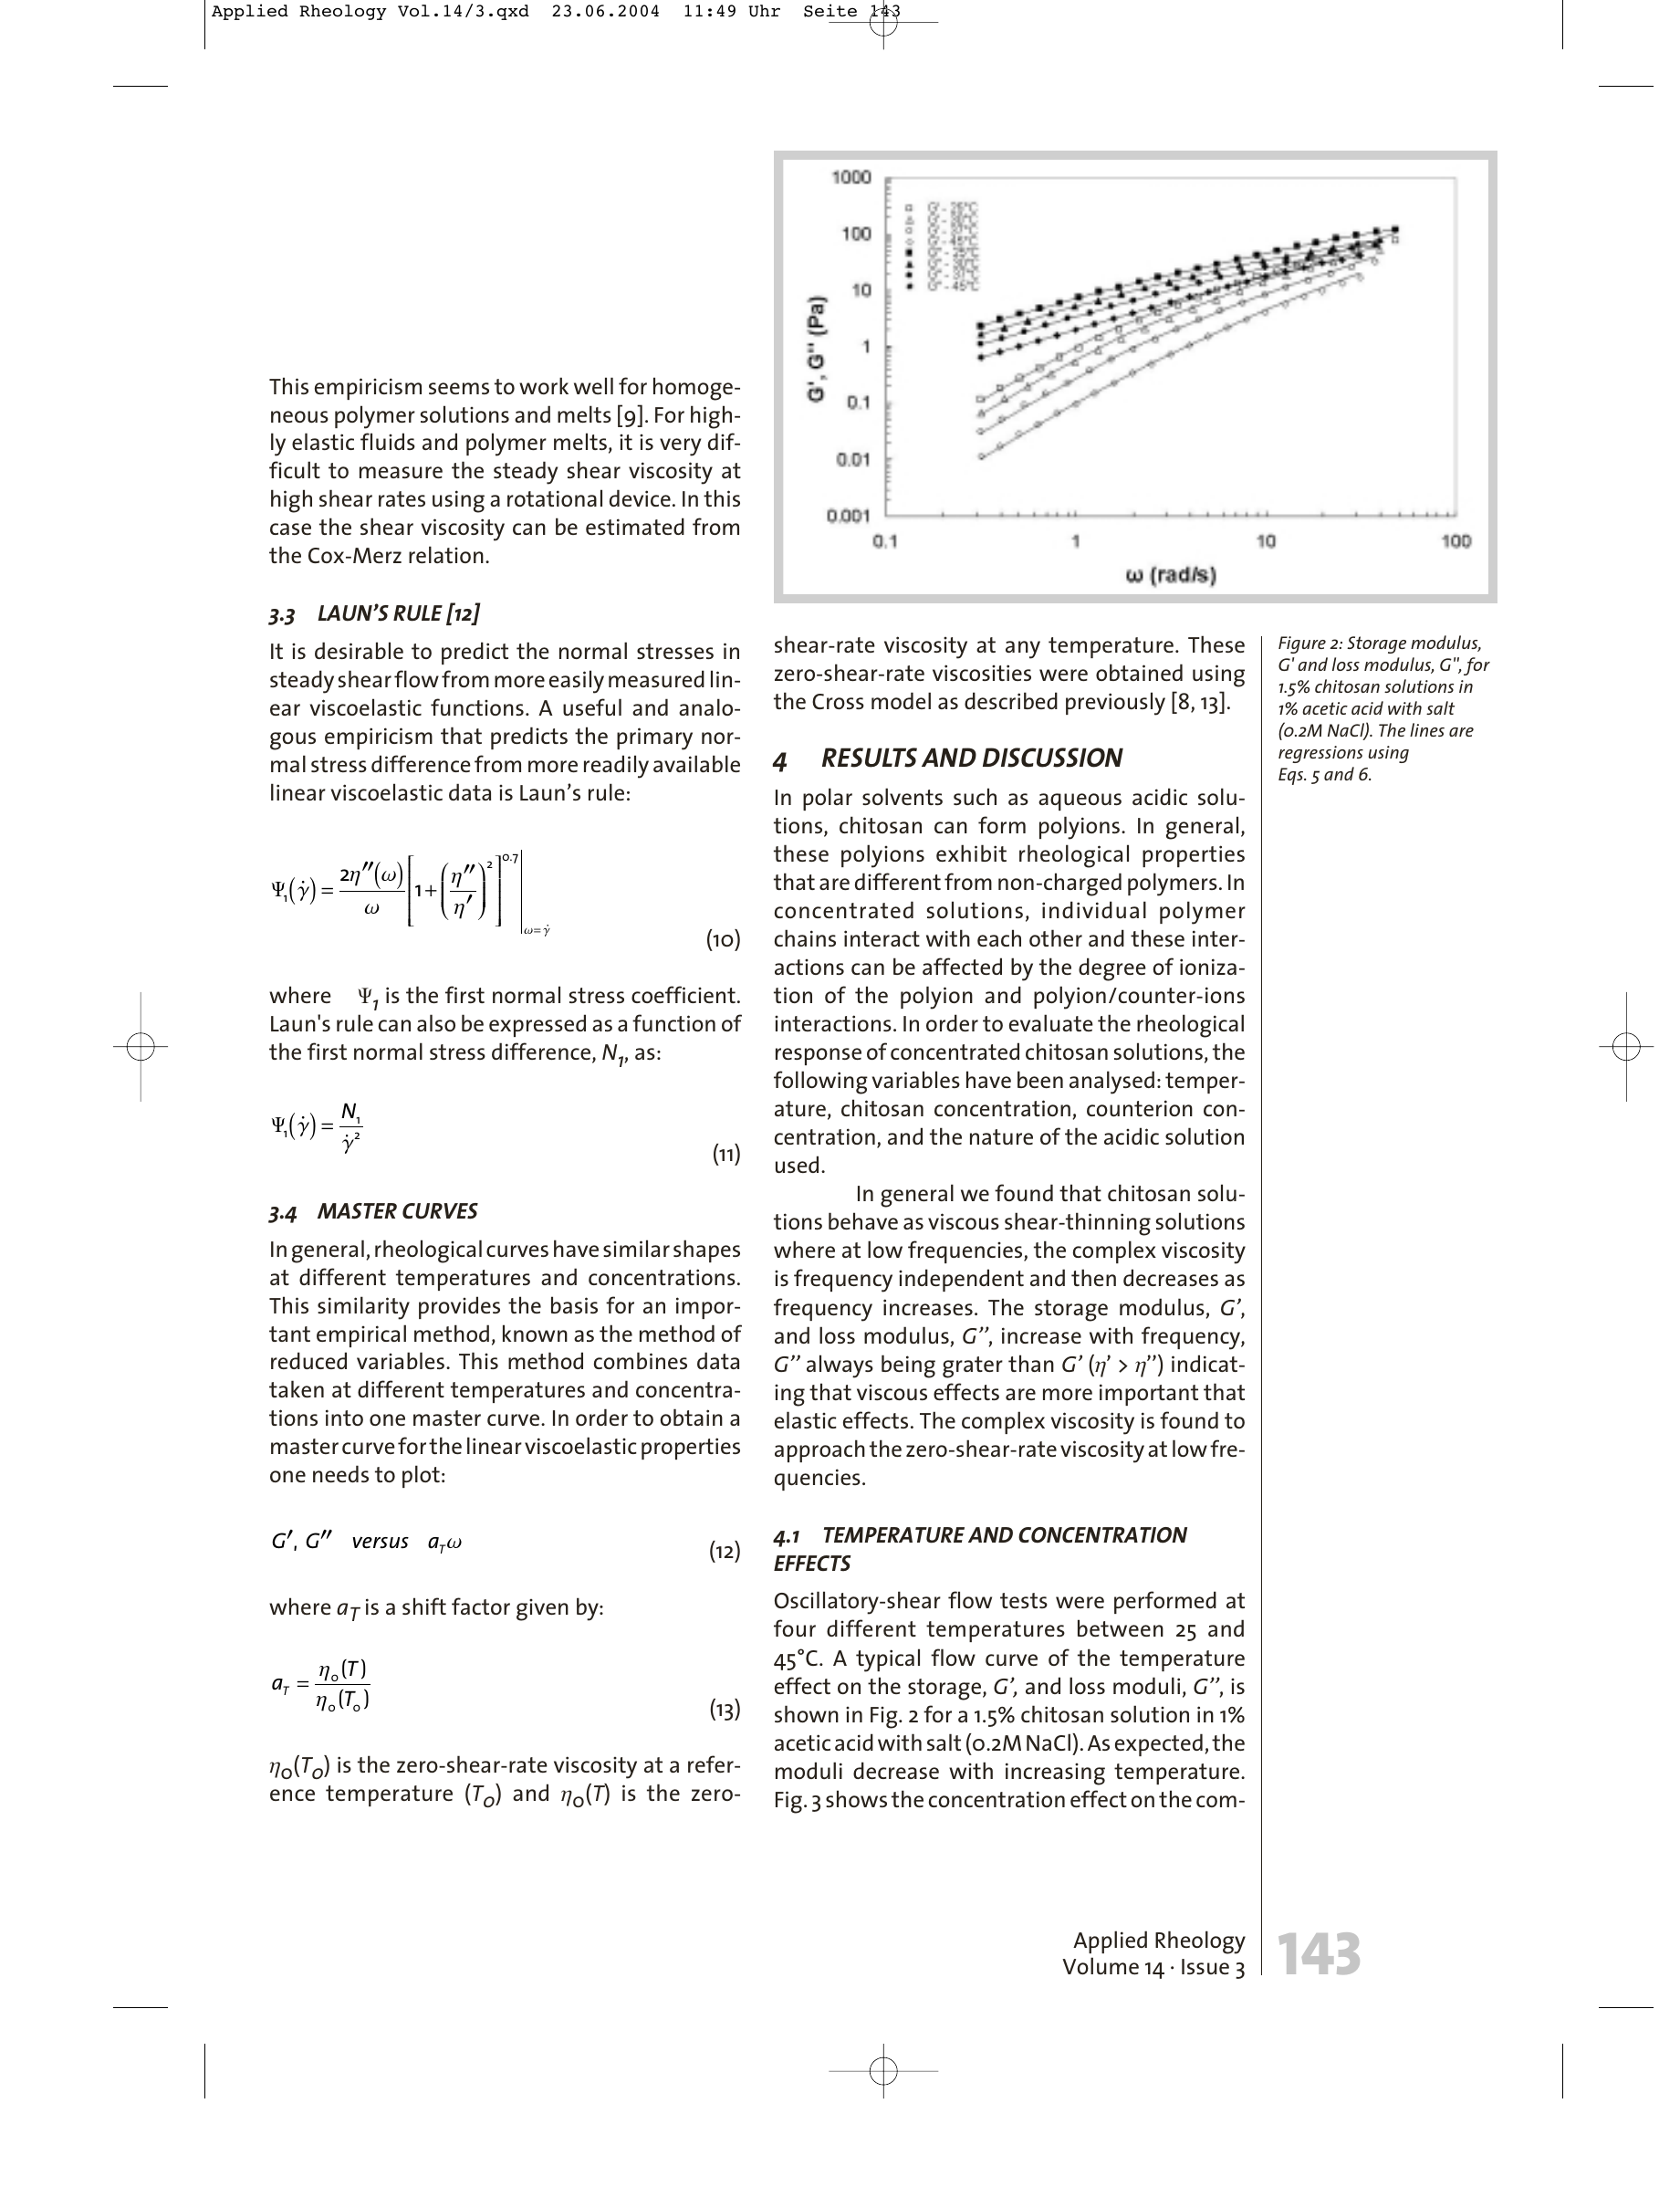
Figure 2: Storage modulus, G' and loss modulus, G'', for 1.5% chitosan solutions in 1% acetic acid with salt (0.2M NaCl). The lines are regressions using Eqs. 5 and